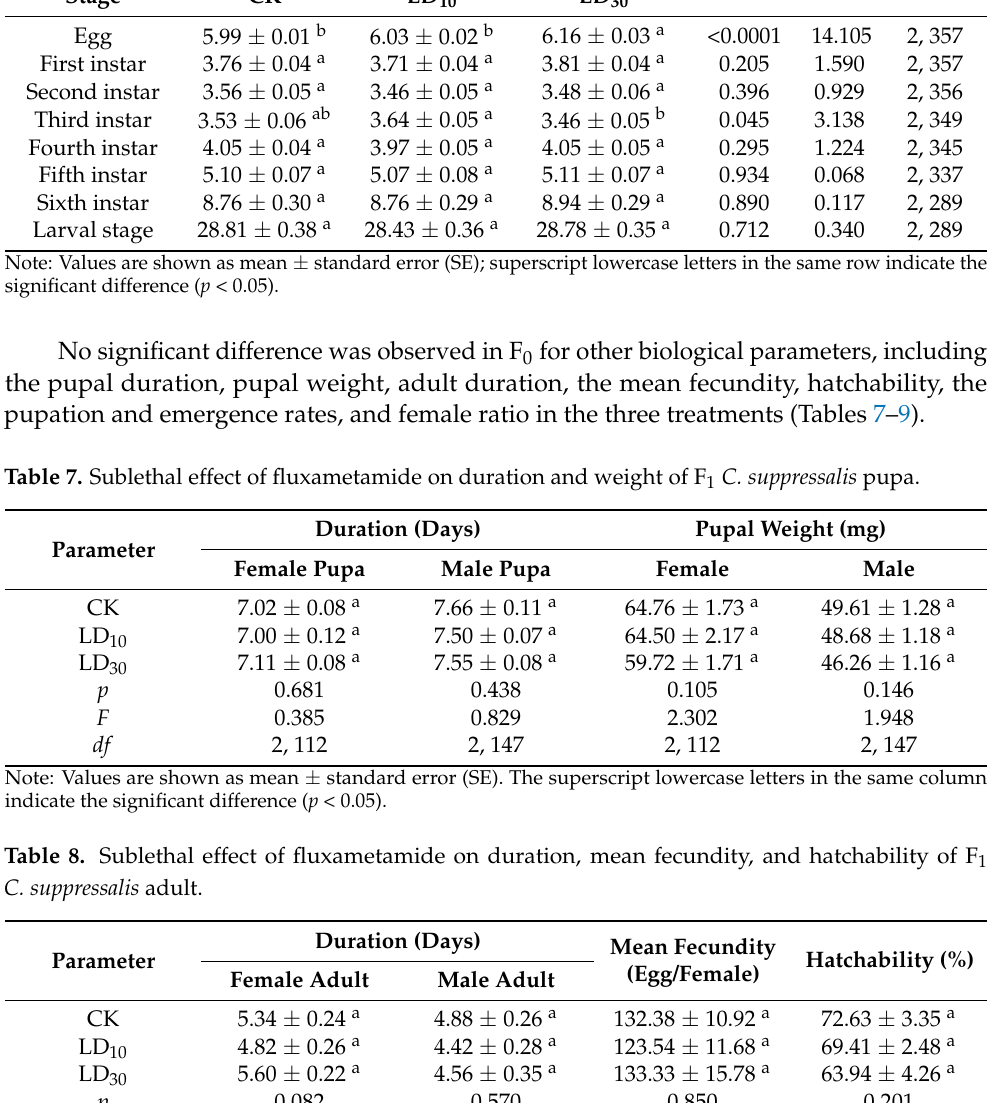
Table 6. Sublethal effect of fluxametamide on duration of F 1 egg and larvae of C. suppressalis. Developmental